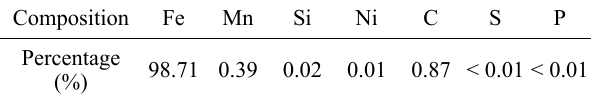
Table 1 Chemical compositions of specimens.